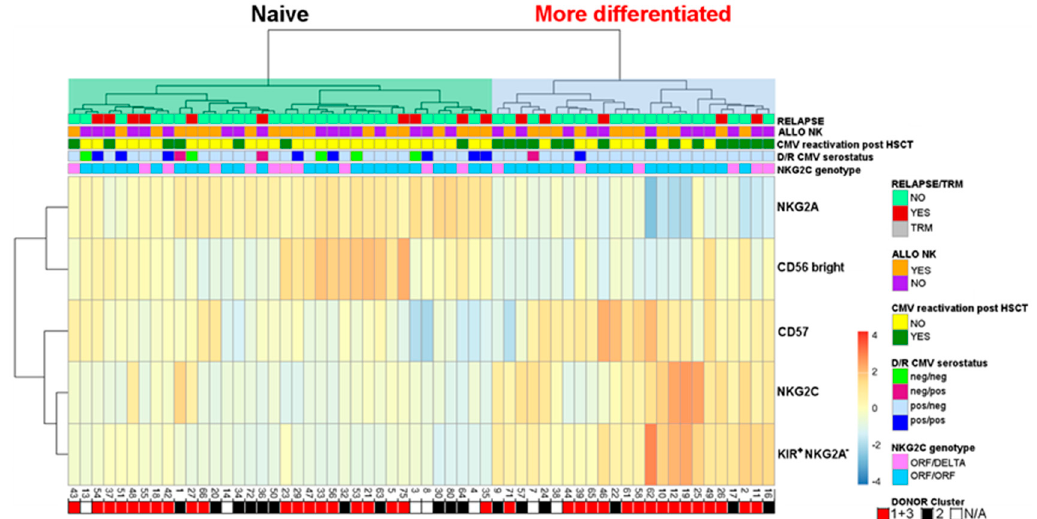
Figure 4. Hierarchical clustering of post-transplant repertoires. Unsupervised hierarchical clustering of NK-cell repertoires in 60 patients at 3–6 months after HSCT allowed the identification of two main clusters, namely cluster 1 with “naïve” and cluster 2 with a more differentiated repertoire. Data were based on multi-color flow-cytometry, analyzing the frequencies of CD56 bright , or, among the CD56 dim , the frequencies of NKG2A + , CD57 + , NKG2C + , and KIR + NKG2A − NK cells. Information on clinical and biological observations is annotated in the top bars above and to the right of the heat map. Z-scores were calculated and used to scale for visualization across rows in the heat map. High (red) and low (blue) frequencies of each subset are represented in the color scale. Underneath the heatmap, red and black squares indicate the cases whose respective donors showed NK cells with “differentiated” (identified by cluster 1 + 3) and “naïve” (identified by cluster 2) phenotype, respectively, as shown in Figure S4, while white squares indicate when there is no available donor data (NA).